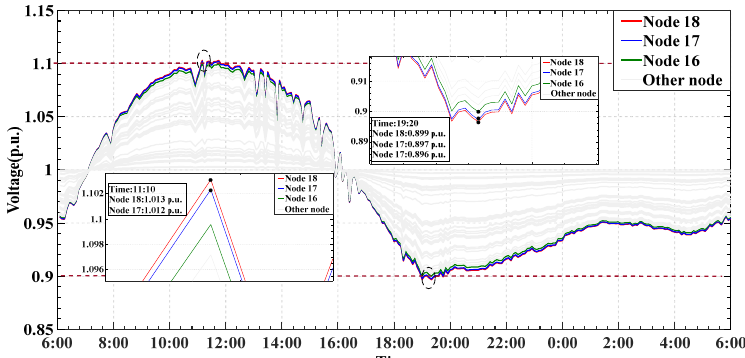
Figure 6. The voltage curves before regulation.